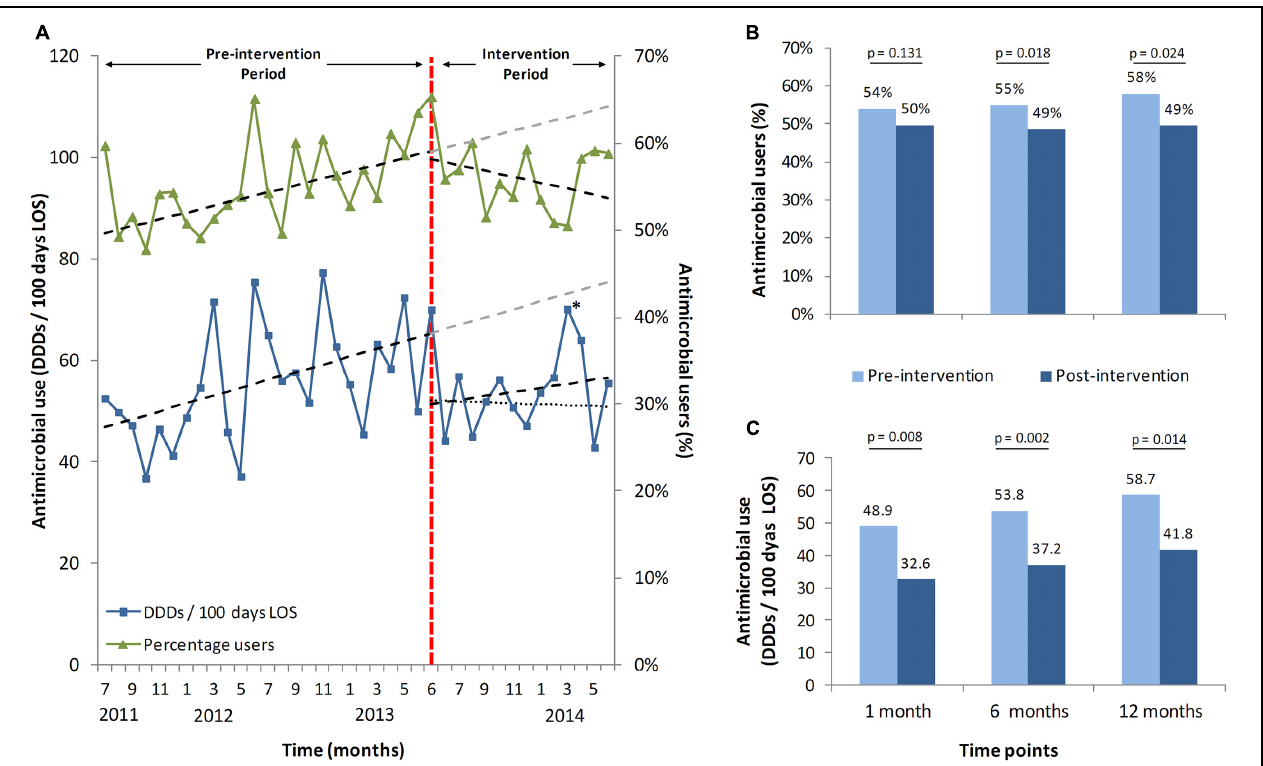
FIGURE 2 | Antimicrobial stewardship-team (A-Team) effects on the whole ward. (A) trends of percentages of all patients on the ward receiving antibiotics with and without intervention(s) and respective DDDs per 100 patient days. Shown are 2 years before the intervention started (June 2013), until June 2014, including trend lines and predicted trend lines. A second dotted trend line for the mean DDDs depicts the trend without the outlier patient from April 2014 ( ∗ ). (B) predicted and